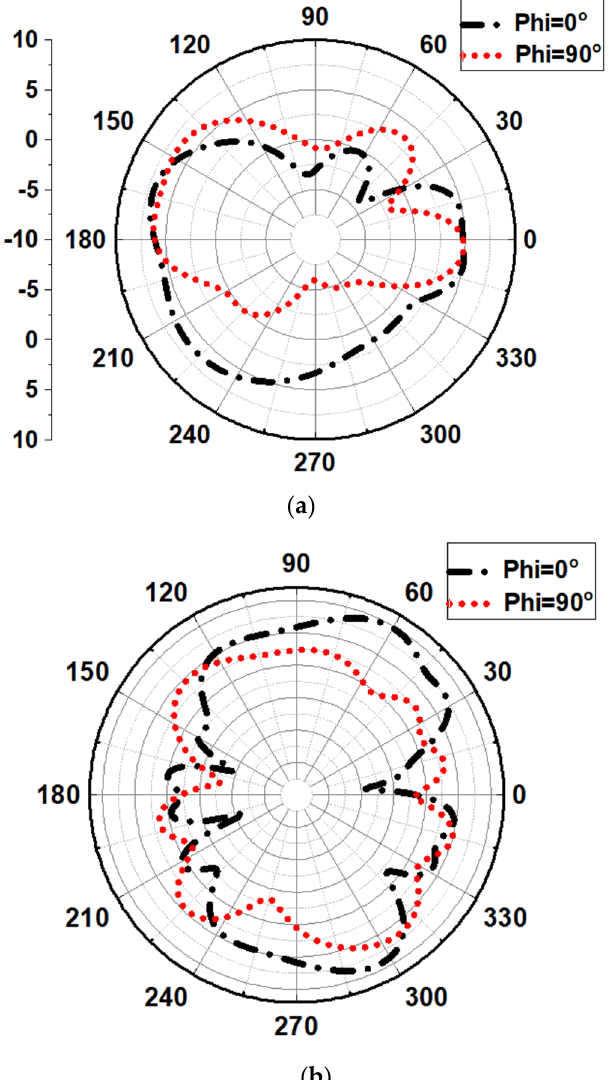
GHz, and variation of radiation efficiency vs. frequency for the bandwidth of operation for a resonant frequency of ( c ) 22.7 and ( d ) 34.9 GHz.